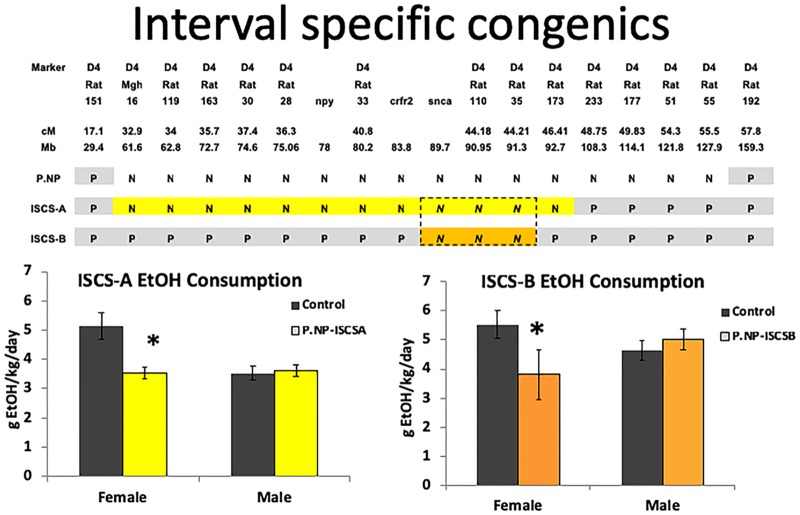
P.NP is the congenic strain with the Chr4 QTL region in P rats replaced by the NP Chr4. Backcrossing P.NP with iP rat resulted in interval-specific congenic strains (ISCS). ISCS-A and ISCS-B shared a narrowed Chr4 QTL between 83.8 and 92.7 Mb (region in dash-lined box). Relative to iP control rats, only females in either ISCS consumed less alcohol; alcohol consumption (gEtOH/Kg/day) was calculated and is shown as mean ± SEM. ∗indicates p < 0.05.